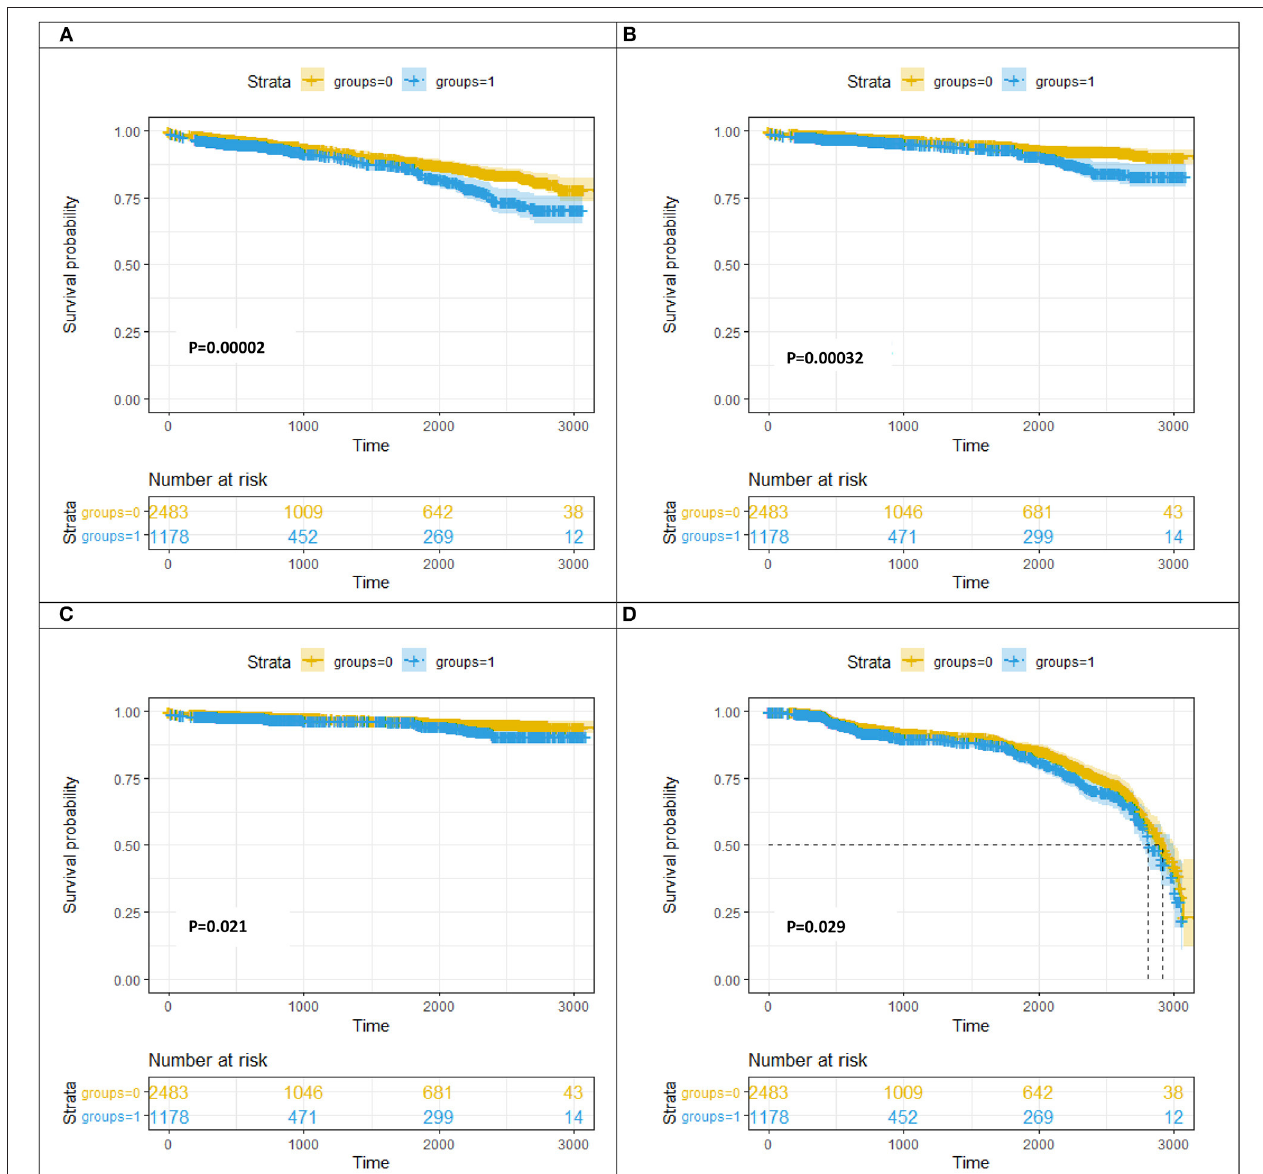
FIGURE 3 | Kaplan–Meier curve analysis for MACE (A) /all-cause death (B) /cardiac-caused death (C) /revascularization (D) at follow-up between the DM group and the non-DM group. DNL, de novo lesion; LST, late stent thrombosis; VLST, very late stent thrombosis groups = 0, non-diabetes mellitus group; groups = 1, diabetes mellitus